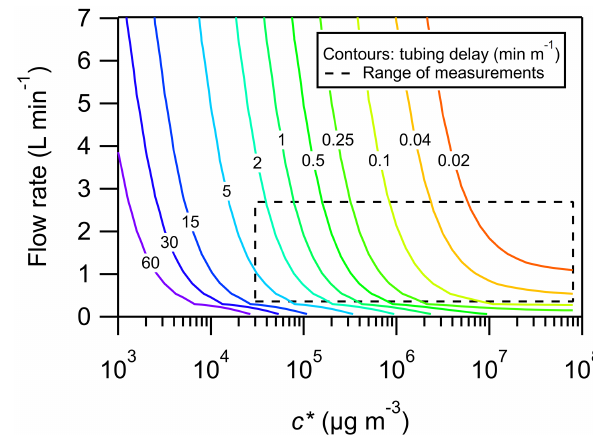
Figure 4. Comparison of modeled and measured tubing delays for homologous series of 2-ketones and 1-alkenes with a range of c ∗ values using short (ST = 1m) and long (LT = 3m) lengths of 3/16in. ID tubing with low (LF = 0.36Lmin − 1 ) flow and long tub- ing with low and high (HF = 2.7Lmin − 1 ) flow. The instrument de- lay for the PTR-MS is also shown. Values of c ∗ were calculated using SIMPOL.1 (Pankow and Asher, 2008). Error bars are only shown for the 2-ketone LF/ST case, and represent the variability (SD) of the observations. Note that for the larger delays, the error bars are smaller than the data points.